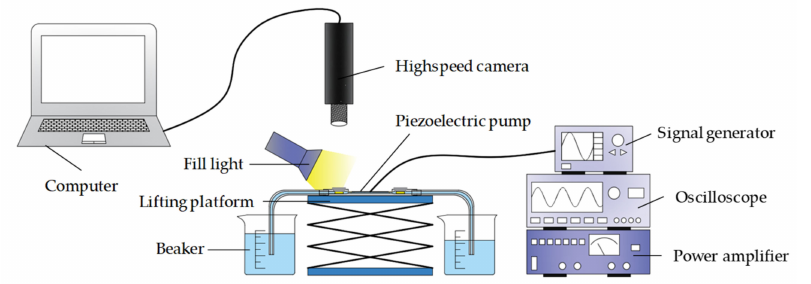
Figure 13. Observation test platform.